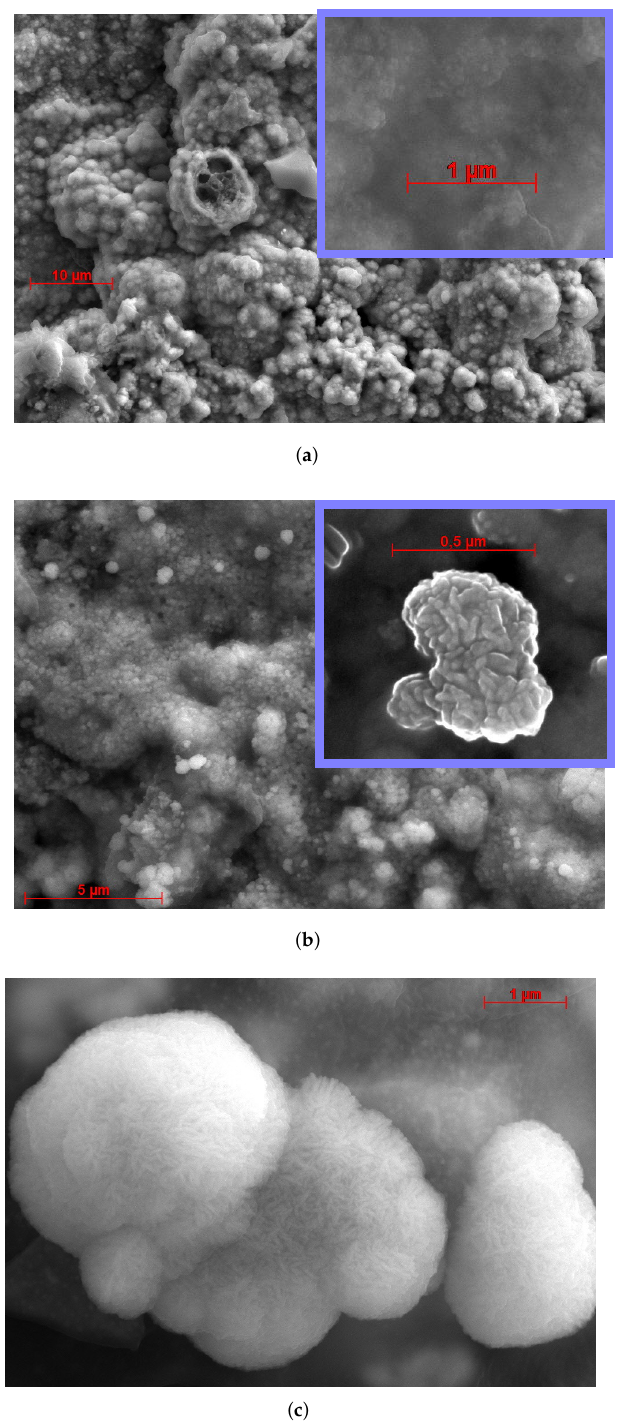
Figure 3. SEM images of Cu-based electrodes. ( a ) Pure Cu electrode; ( b , c ) Cu–Ru electrode. The in- serts in blue squares show the microstructure of these electrodes. SEM images were obtained using the secondary electrons mode with 20 kV accelerating voltage. One can see that both electrodes have developed porous surface and demonstrate an obvious hierarchical structure—large pores and protrusions that contain small irregularities. Moreover, the surface of Cu–Ru electrode consists of ruthenium islands spread on top of the Cu layer (see Figure